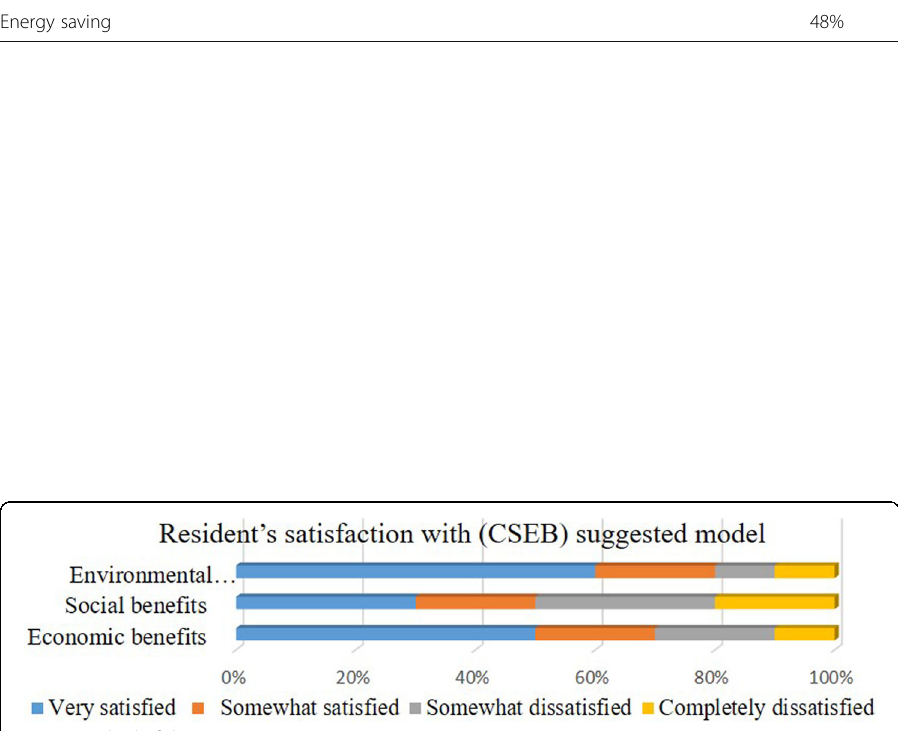
Fig. 9 Resulted of the screening